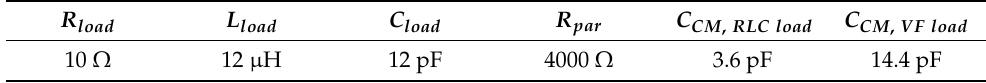
Table 6. Parameters of the load model depicted in Figure 22. The parameters R load and L load describe the connected resistor and inductor. The values for C load , R par , C CM , RLCload , and C CM , VFload were extracted from DM and CM measurements to model the first parallel self-resonance of the inductor and the capacitive coupling towards the metal